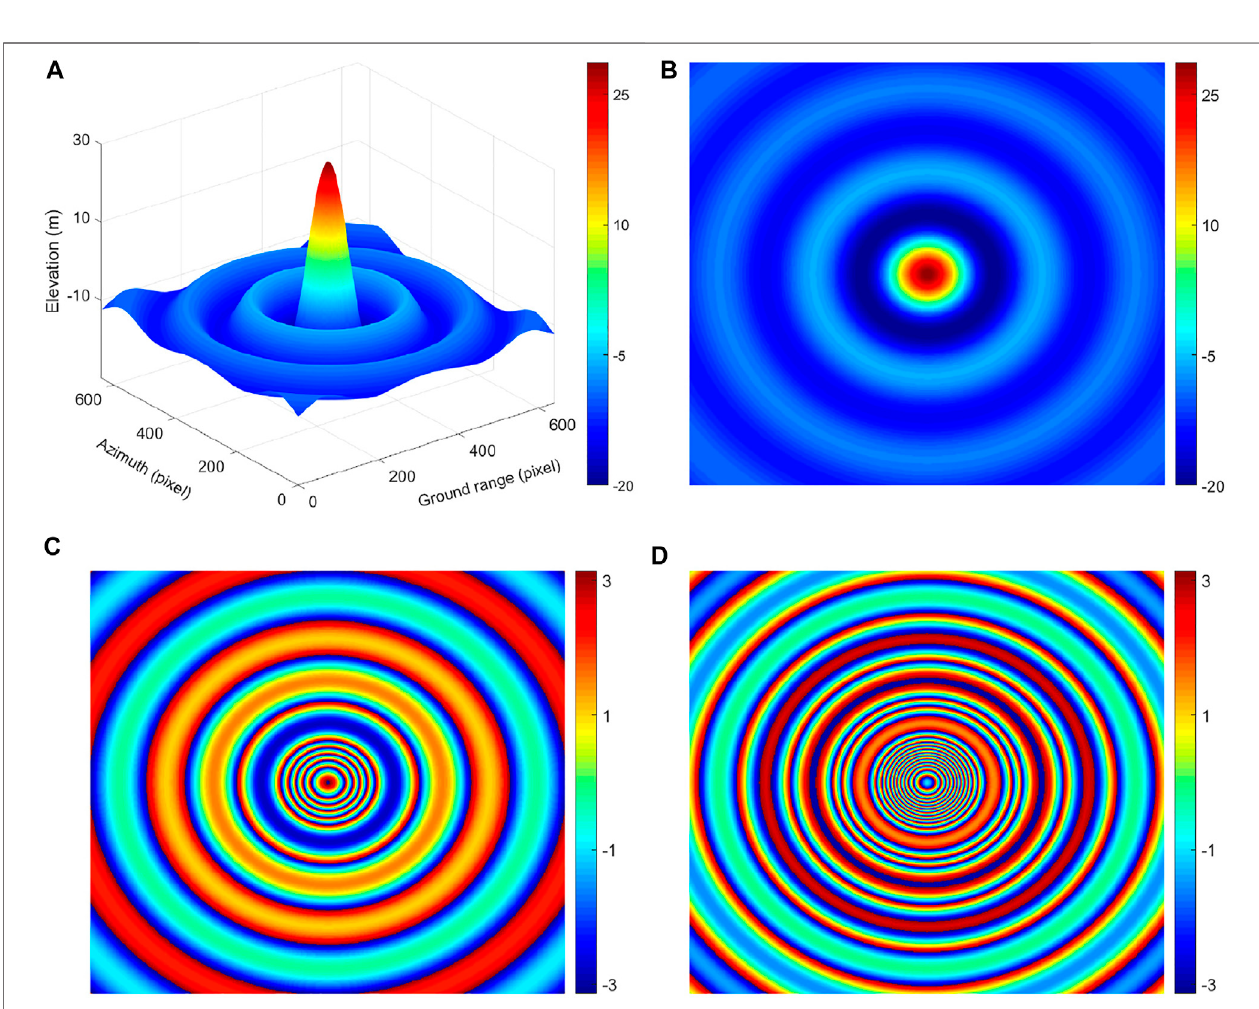
FIGURE 10 | Sinc function. (A) 3D DEM (m). (B) 2D DEM (m). (C) Simulated short-baseline interferogram (rad). (D) Simulated long-baseline interferogram (rad).